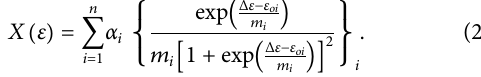
For the two isotherms, brown and blue, the corresponding energy distribution function (EDF) curves are shown in the exact fi gure at the bottom right corner in Figure 1 . The color of the EDF curves corresponds to the same color isotherms. The universal isotherm model successfully de fi ned all isotherm types and understood the formation of such